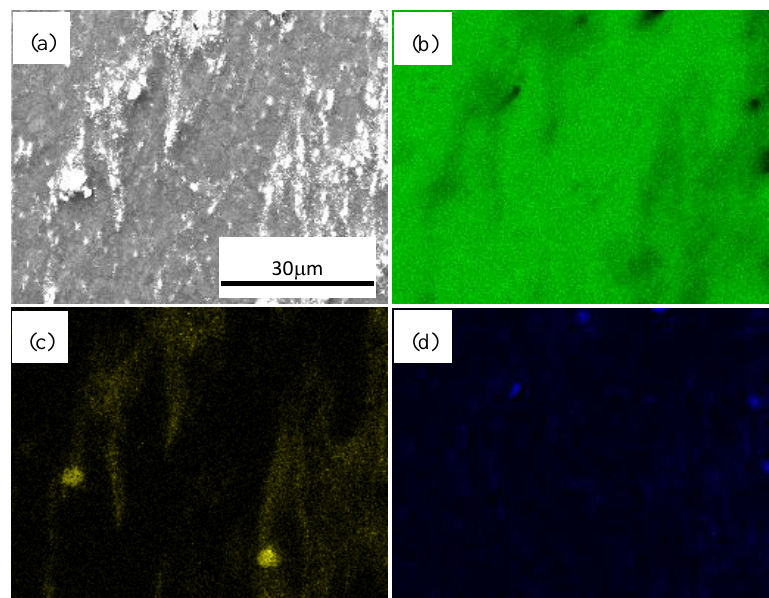
Figure 8. SEM micrographs at high magnification of nano-SiCp/AZ91 composite after 6 passes at 400 °C and 3 passes at 350 °C: ( a ) ditribution of SiC nanoparticles, energy dispersive spectroscope (EDS) of ( b ) Mg K; ( c ) Si K; ( d ) Al K.